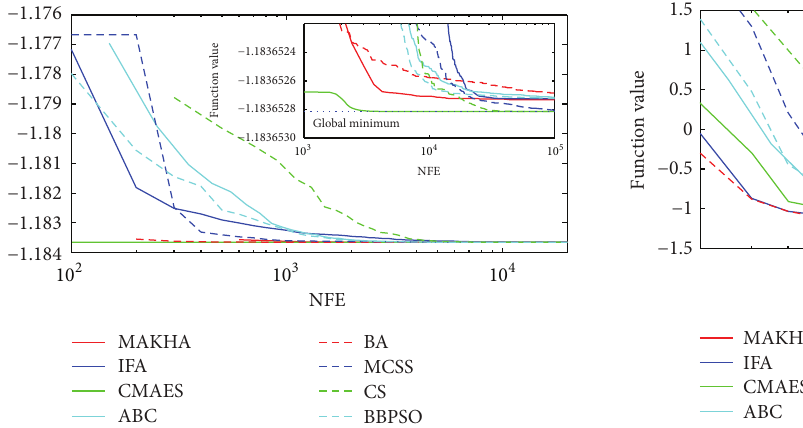
Figure 8: The evolution of the mean best value calculated via the eight metaheuristics versus NFE for problem